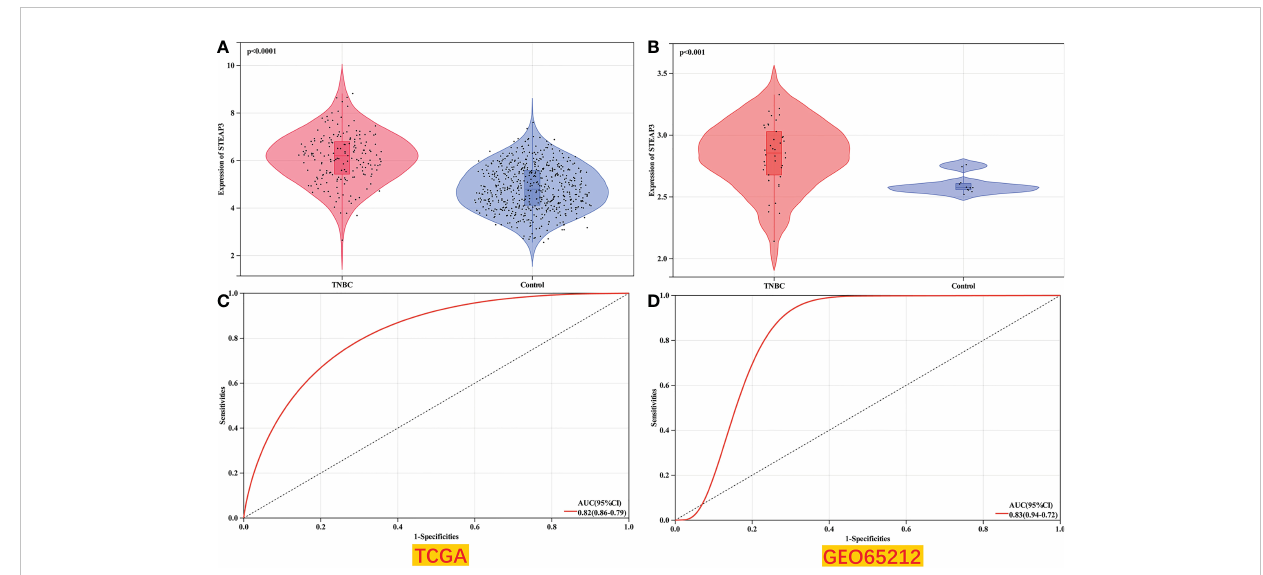
FIGURE 7 Validation of TNBC patient STEAP3 expression levels in GEO datasets. (A, B) STEAP3 expression levels were compared between TNBC and normal tissue samples in the selected TCGA ( P <0.0001) and GEO ( P <0.001) datasets. (C, D) AUC analyses for the TCGA and GEO